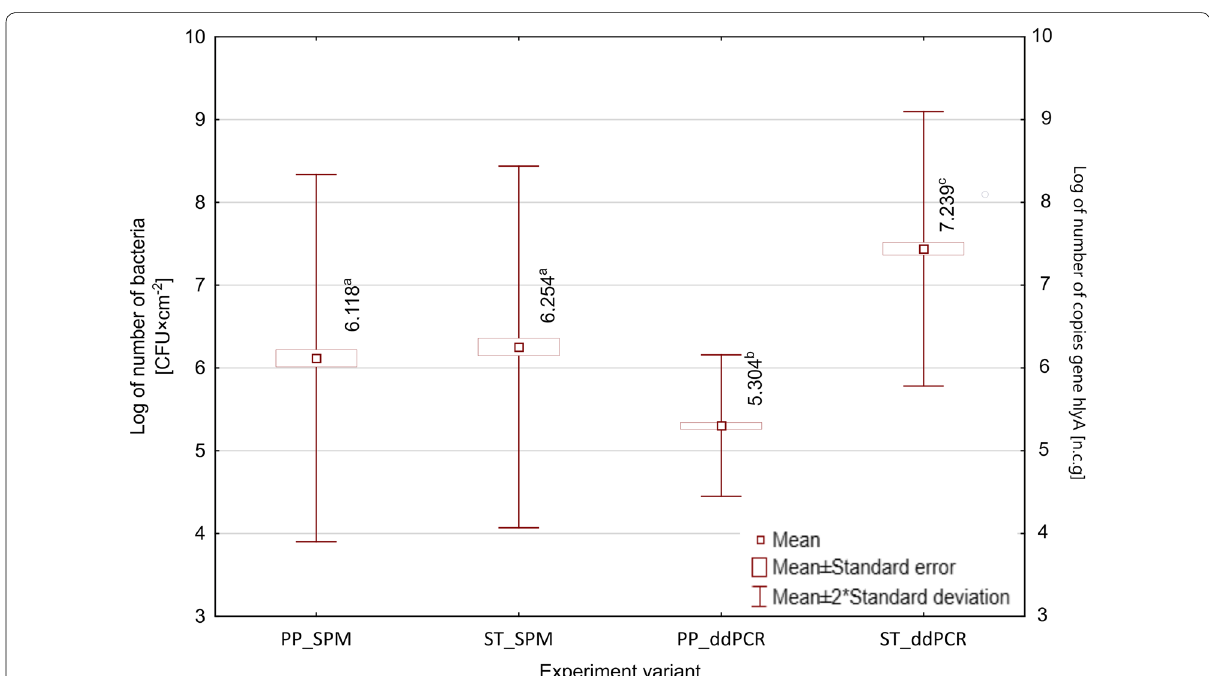
Fig. 2 Differences in the intensity of biofilm formation by the tested L. monocytogenes strains on the surface of polypropylene and stainless steel. a, b, c,… ‑ values marked with different letters are significantly different (p ≤